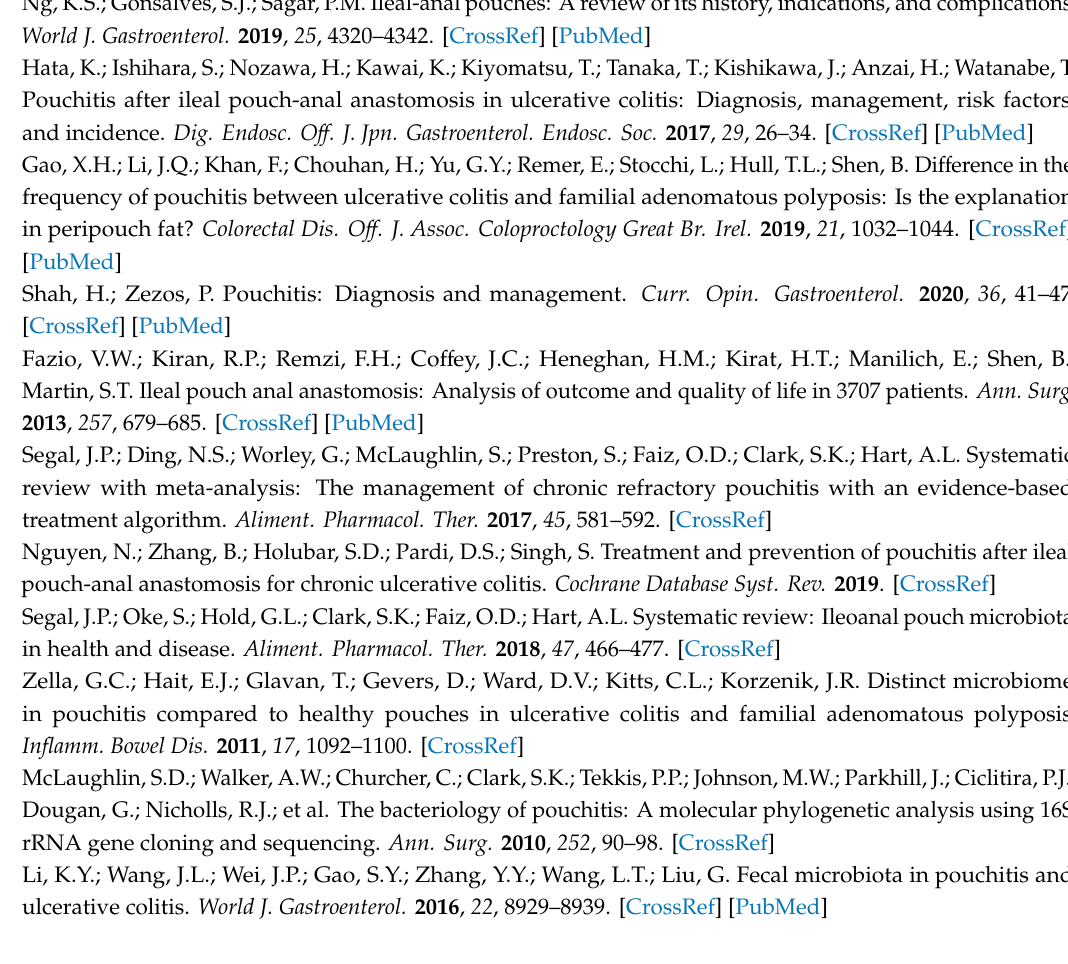
Table S1: Search strategy, Table S2: Quality assessment of controlled, interventional studies, Table S3: Quality assessment of cohort studies, and Table S4: Quality assessment of